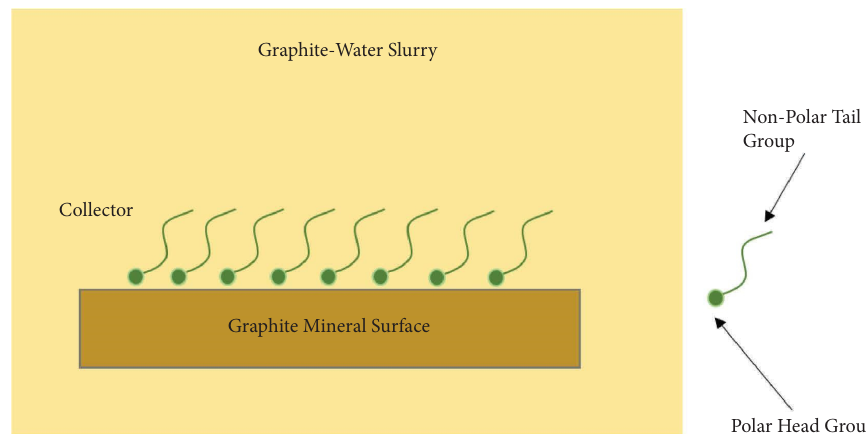
Figure 4: Polar ends of collector interaction on the surface of graphite ore